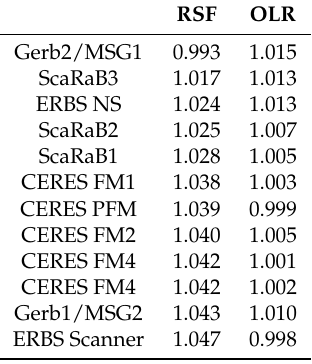
Table 7. Adjustment factors of instruments. RSF: Reflected Solar Flux; OLR: Outgoing Longwave